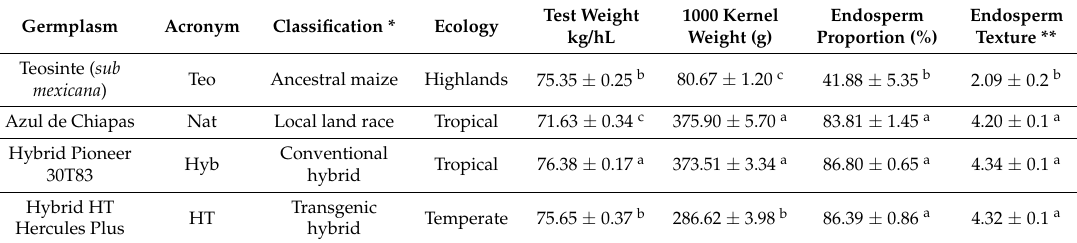
Table 4. Properties description of Zea germplasm used for the zein peptides bioactivity